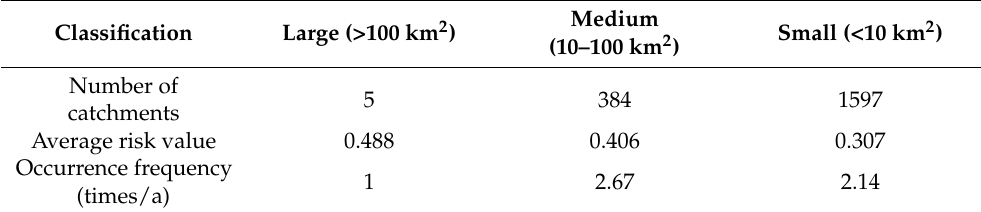
Table 4. Debris flow risk and frequency for each type of